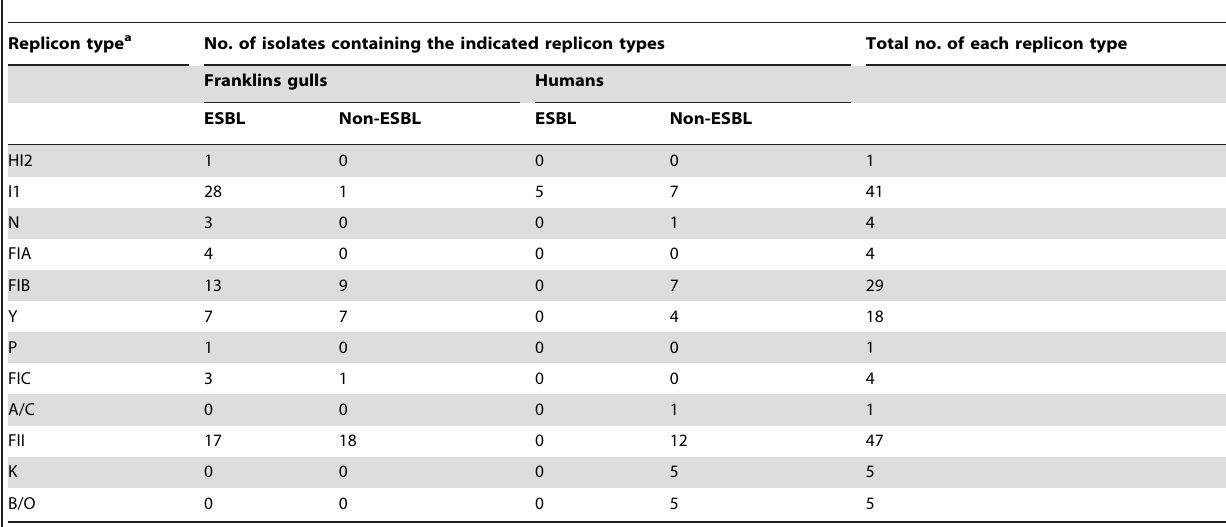
Table 4. The diversity of replicon types identified in the MLST-subset of 150 isolates from Franklins gulls and humans.